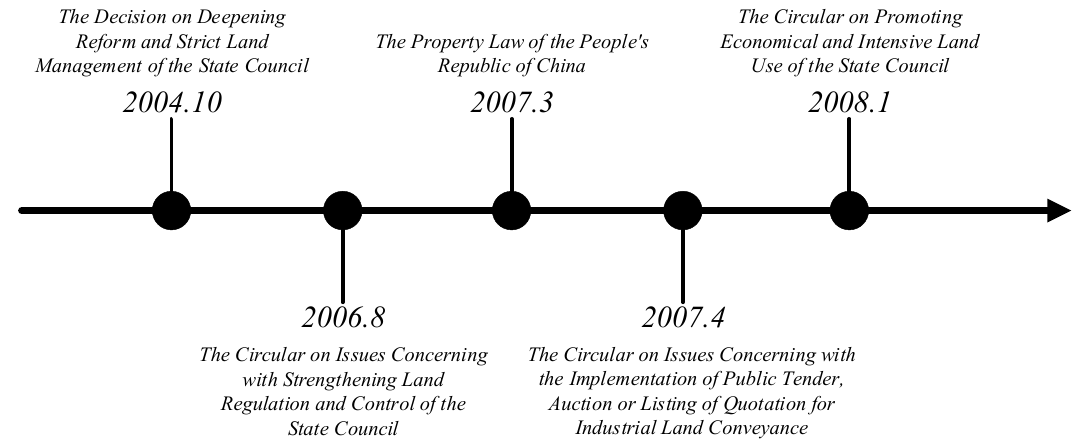
Figure 1. Policy evolution of the market-oriented reform of industrial land in China.